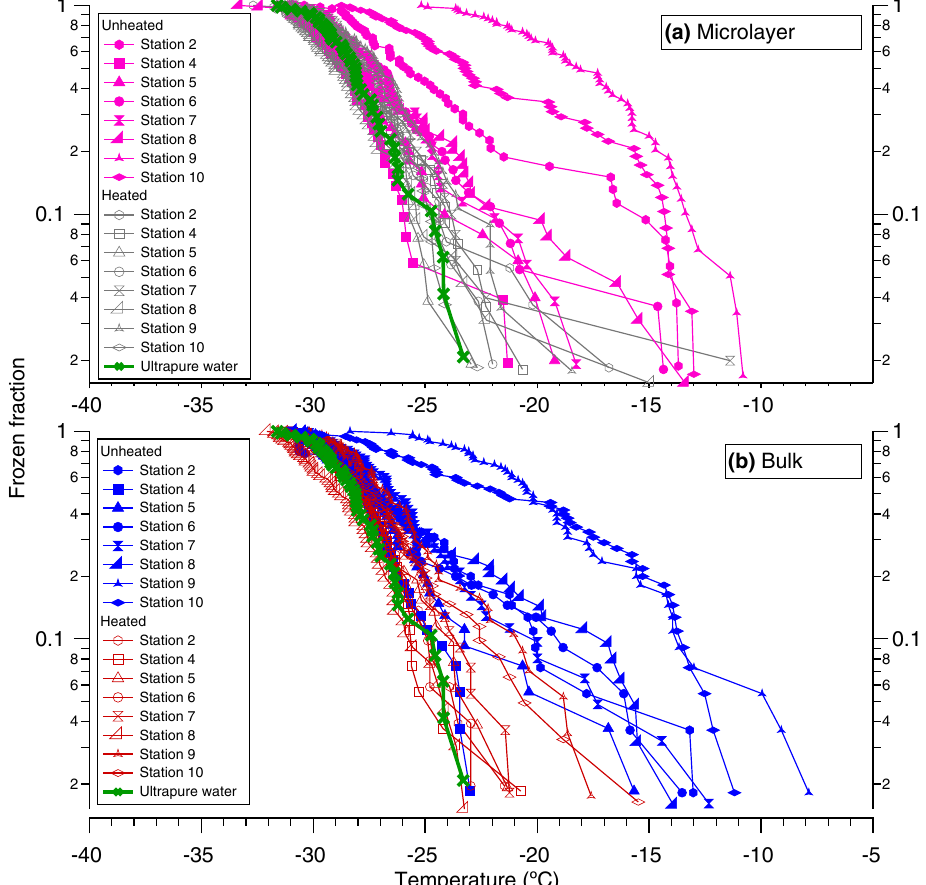
Figure 6. Effect of heating on the frozen fraction for unfiltered samples from microlayer (a) and bulk seawater (b) . Each data point corre- sponds to one droplet freezing event, and all data have been corrected for freezing point depression. The uncertainty in temperature is not shown but is ± 0.3 ◦